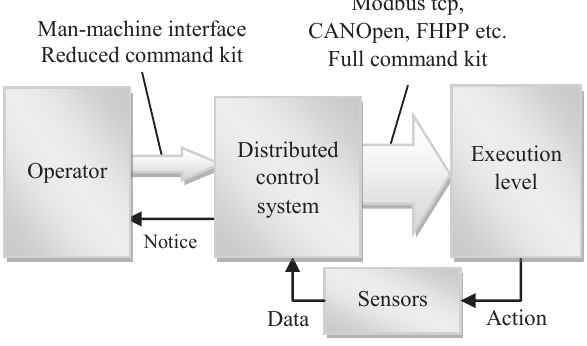
Fig. 2. Operator manipulator control